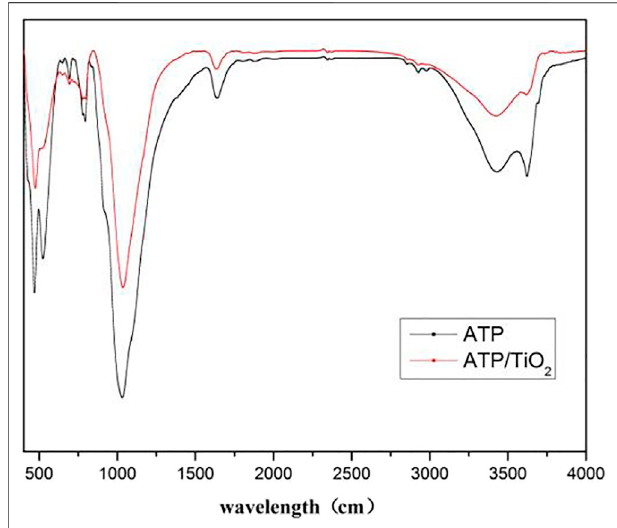
FIGURE 4 | FTIR patterns of ATP and ATP/TiO 2